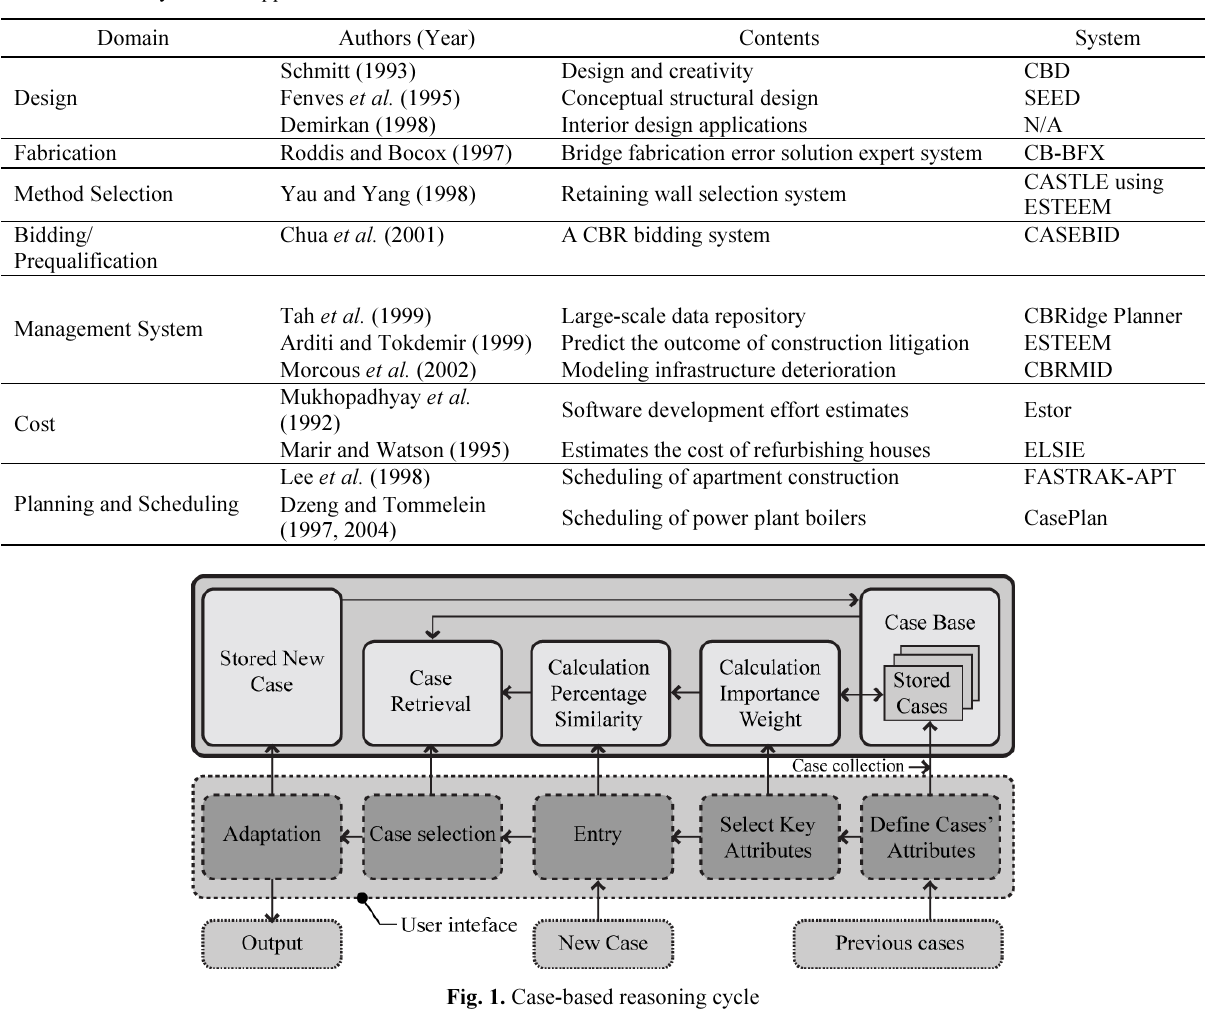
Table 1. Summary of CBR applications in various domains